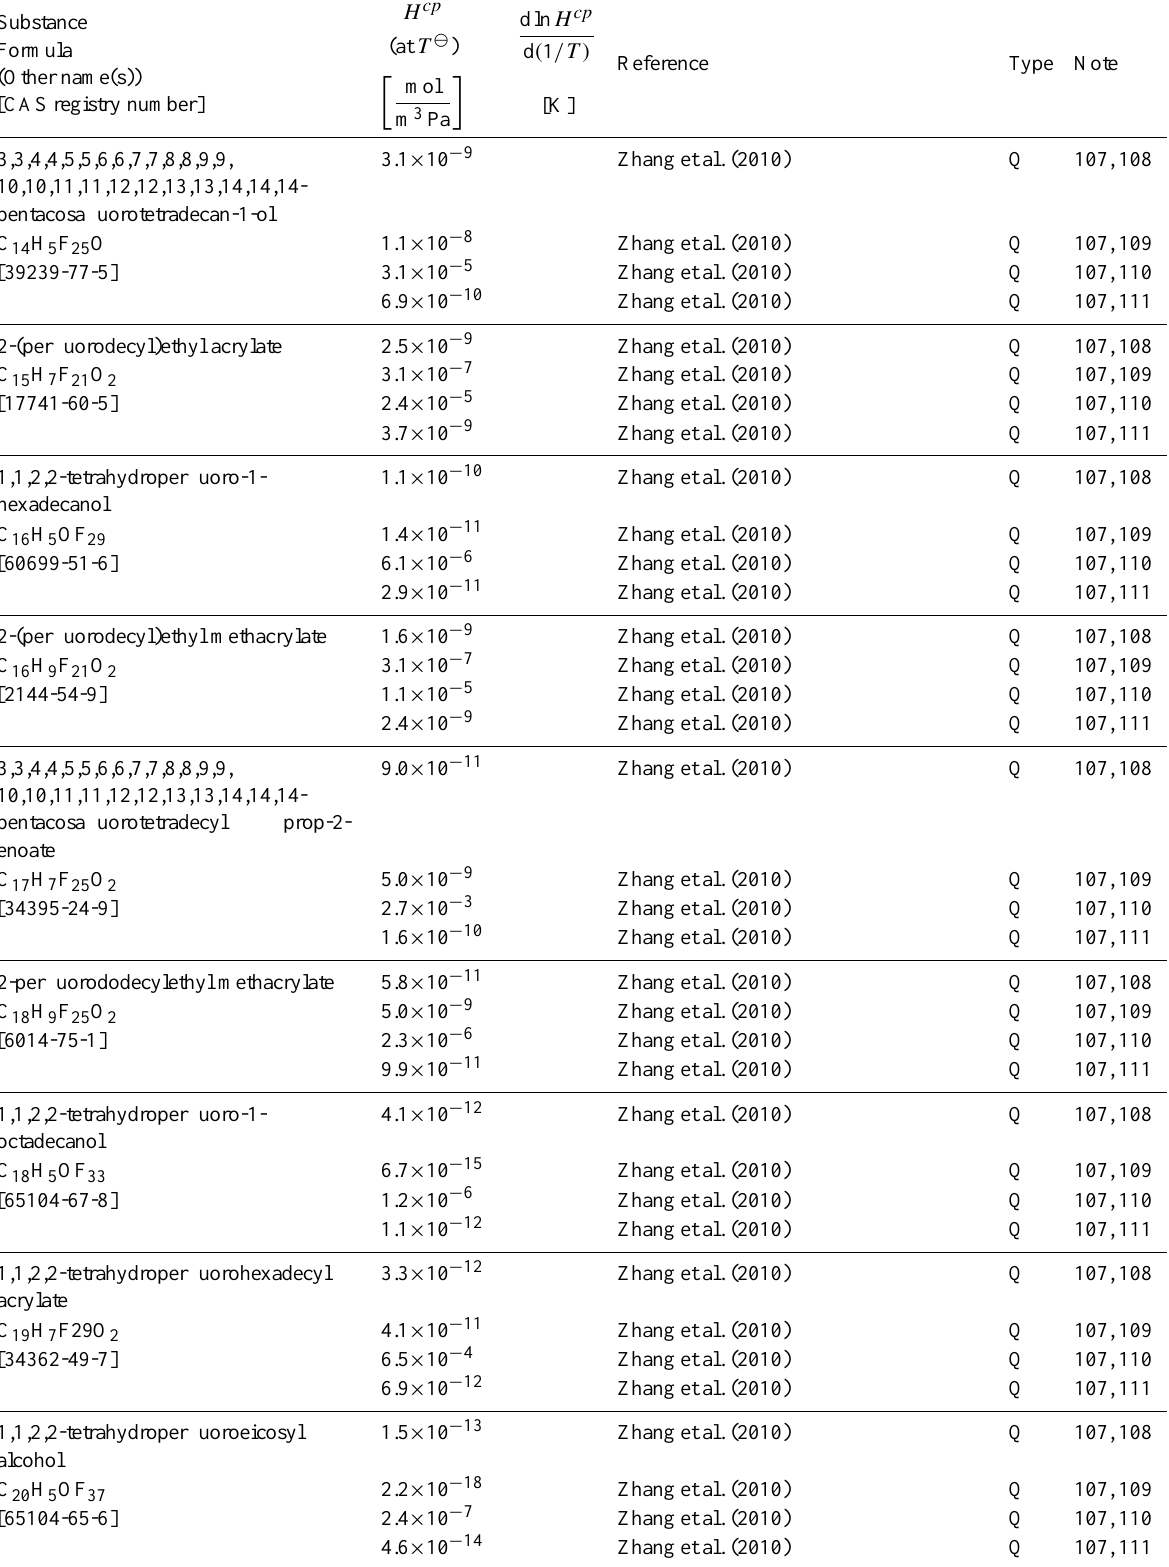
Table 6: Henry’s law constants for water as solvent